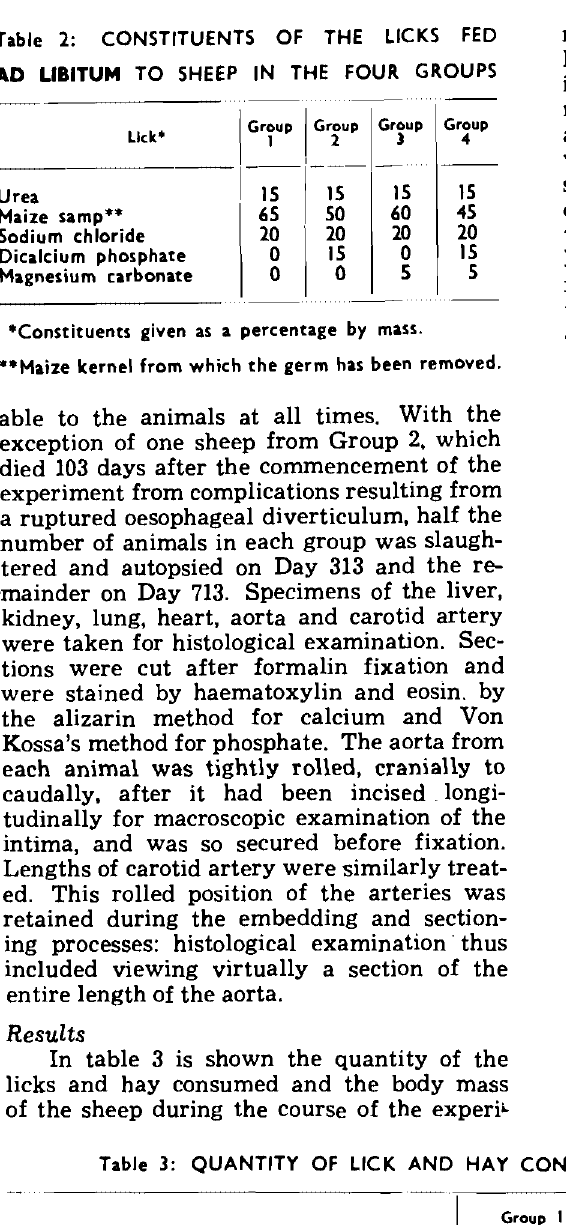
Total quantity hay ingested